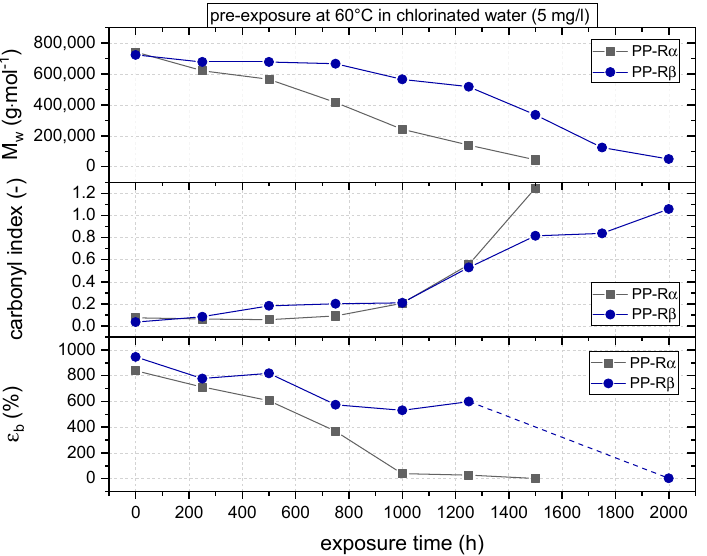
Figure 5. Molecular mass ( M w ), carbonyl index, and strain at break ( ε b ) as a function of exposure time for the two PP-R grades.